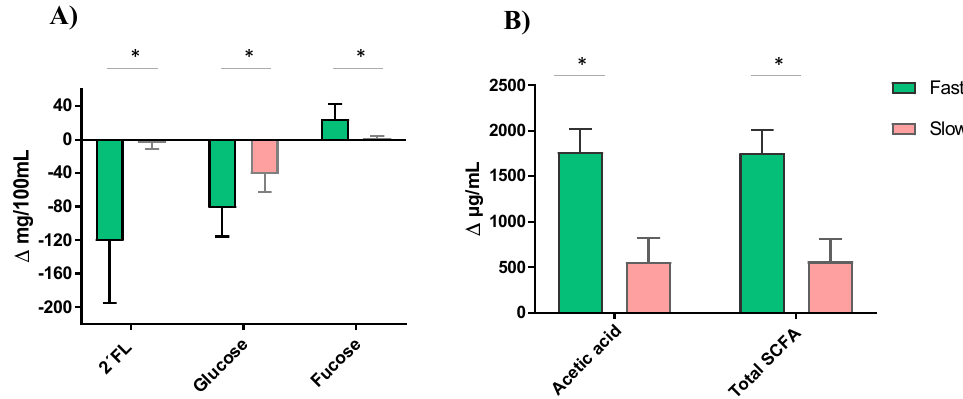
Figure 6. 2′FL degradation and variations in the levels of glucose and fucose ( A ), and acetic and total short-chain fatty acids (SCFA), ( B ) with respect to values in baseline (time 0) after 24 h of incubation in fecal cultures with fast and slow fermenting microbiota profiles. *, Significant differences at p < 0.05.